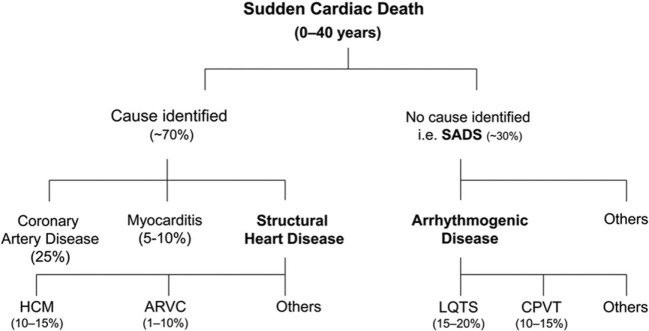
Overview of causes of sudden cardiac death in the young based on post-mortem studies. HCM, hypertrophic cardiomyopathy; ARVC, arrhythmogenic right ventricular cardiomyopathy. LQTS, long QT syndrome; CPVT, catecholaminergic polymorphic ventricular tachycardia; SADS, sudden arrhythmic death syndrome. Reprinted from Semsarian et al. (3) with permission of the publisher.